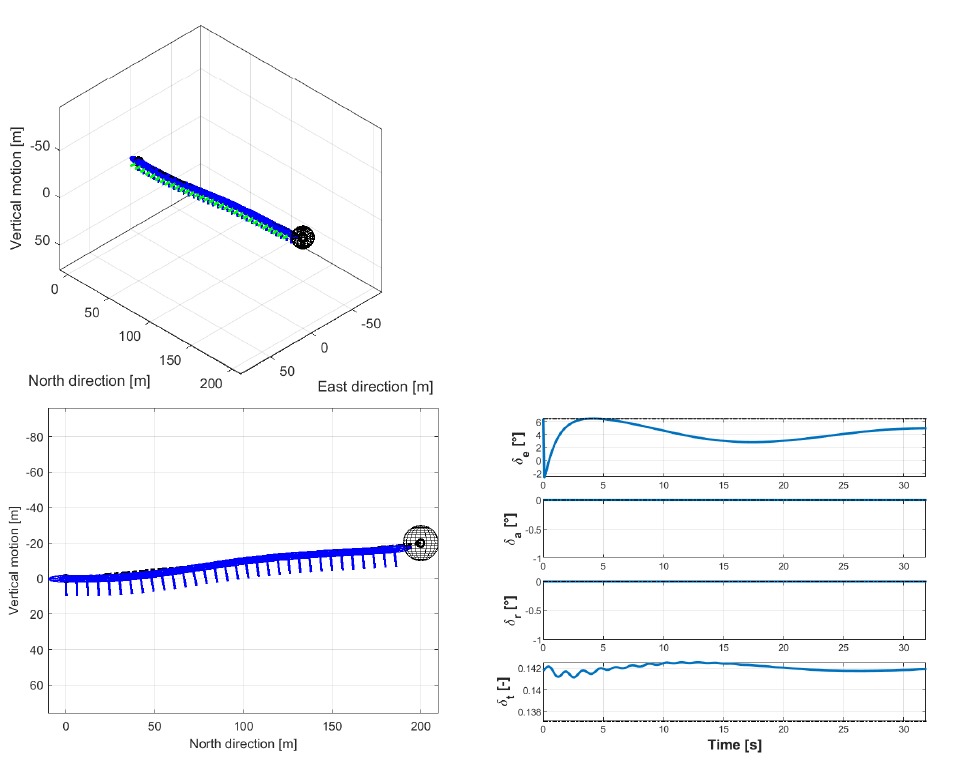
Figure 11. Trajectory and control behavior for an ascending track, as flown by the stabilized baseline airship with the proposed guidance control system. Ground speed setting 6 m/s. ( Top-left ) three- quarter view of the 3D trajectory from the northeast. ( Bottom-left ) view of the trajectory from the east. Black dash-dotted lines: target track. Black spheres: target checkpoint capture volume. ( Bottom-right ) time histories of controls. Black dash-dotted lines: trimmed